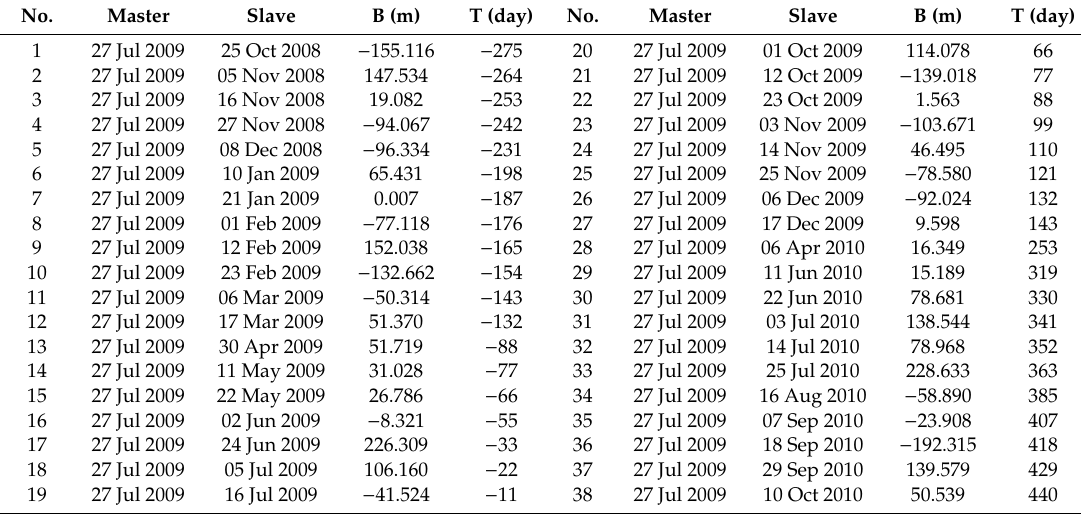
Table 1. Parameters of the formed image pairs. B and T represent the spatial baseline and time interval between the two acquisitions, respectively.